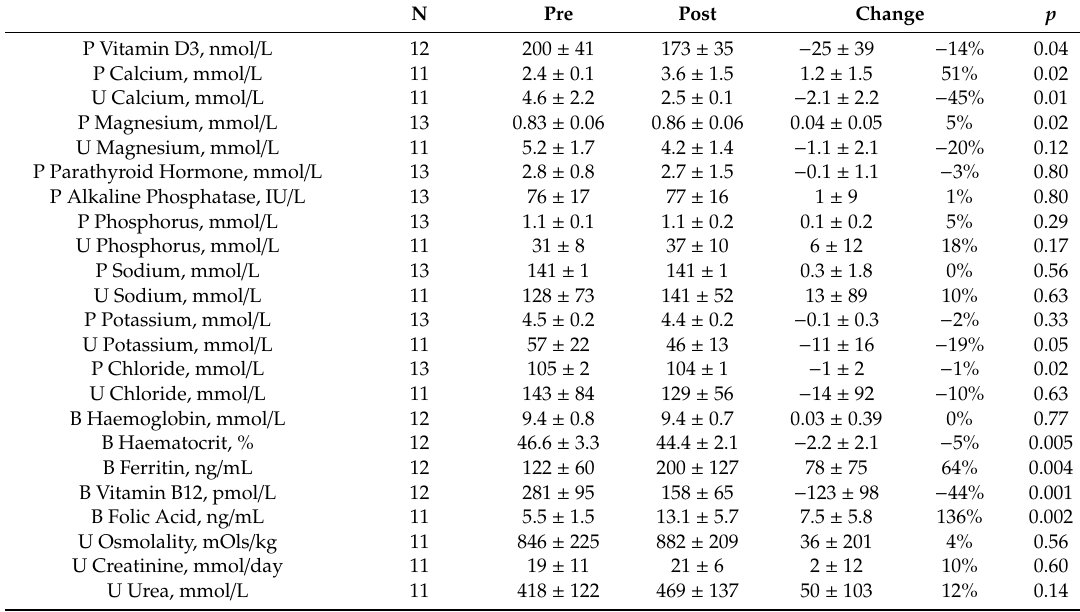
Table 2. Plasma and Urinary